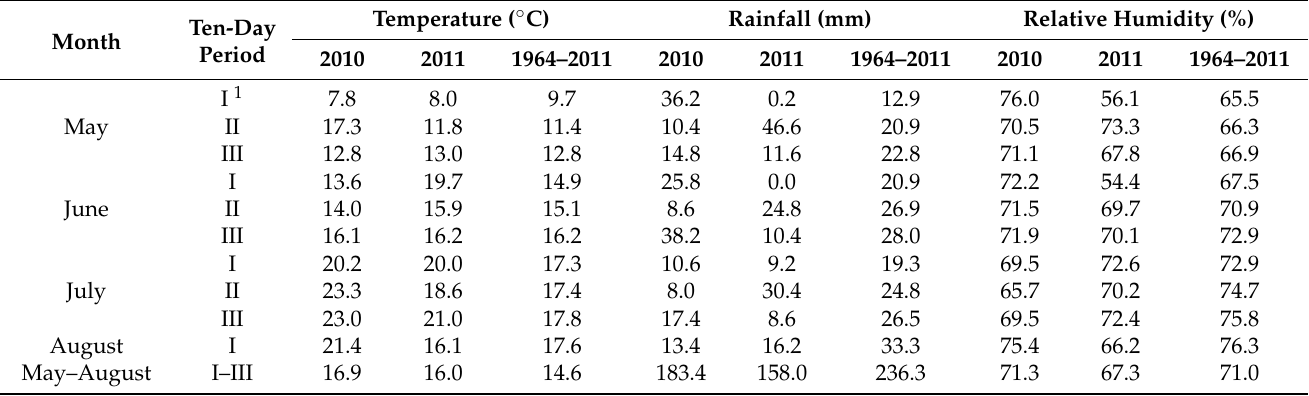
Table 3. Average monthly temperature ( ◦ C), precipitation (mm) and relative humidity (%) in Eerika experimental field during the vegetation period and the corresponding long-term averages